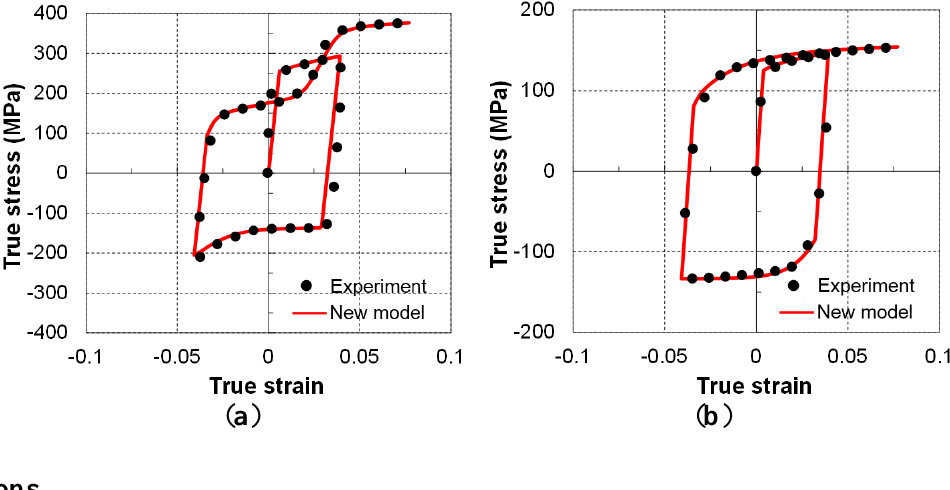
Figure 20. Verification of the proposed hardening model using cyclic test data at: ( a ) room temperature and ( b ) 150